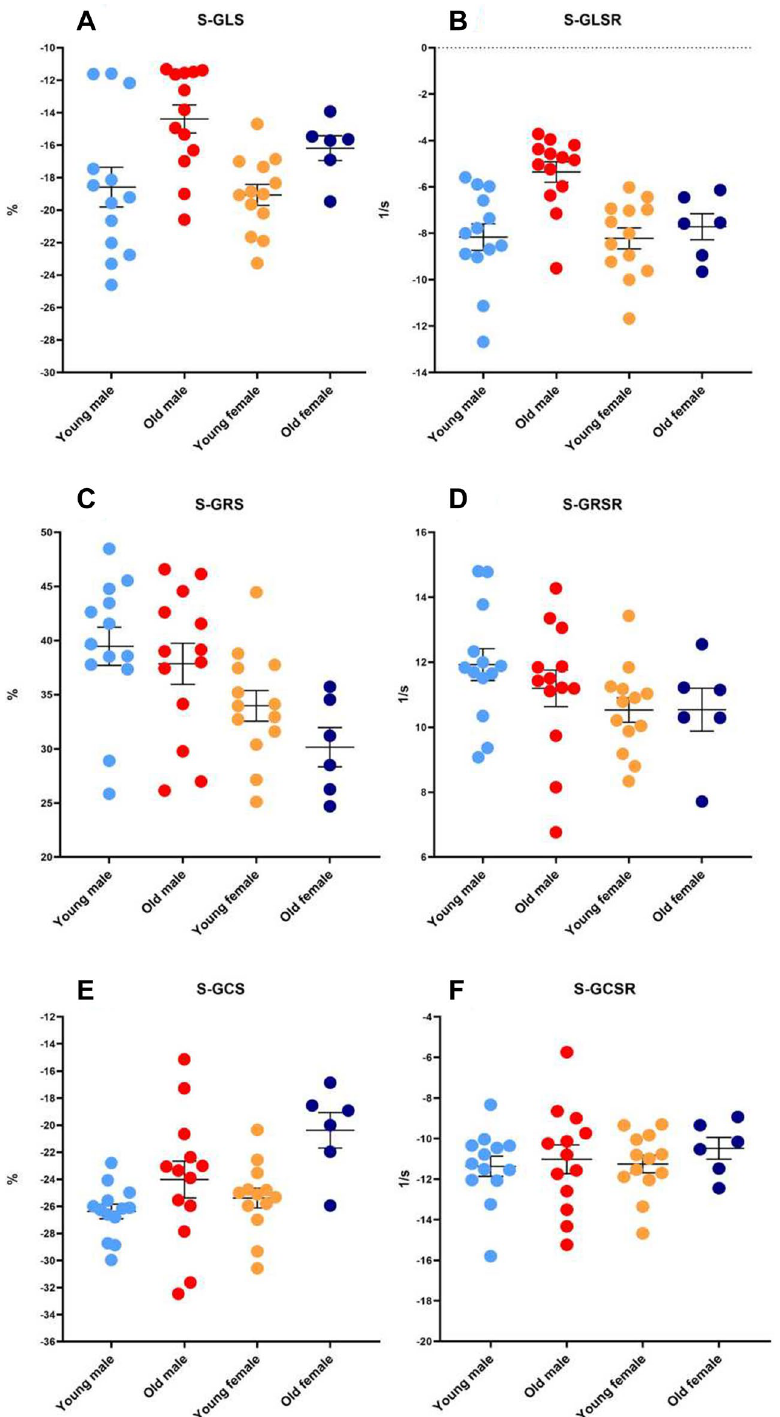
Figure 5. Cardiac systolic functional global strain parameters. ( A ) systolic global longitudinal strain ( B ) systolic global longitudinal strain rate ( C ) systolic global radial strain ( D ) systolic global radial strain rate ( E ) systolic global circumferential strain ( F ) systolic global circumferential strain rate. * S-GLS systolic global longitudinal strain; S-GLSR systolic global longitudinal strain rate; S-GRS systolic global radial strain; S-GRSR systolic global radial strain rate; S-GCS systolic global circumferential strain; S-GCSR systolic global circumferential strain